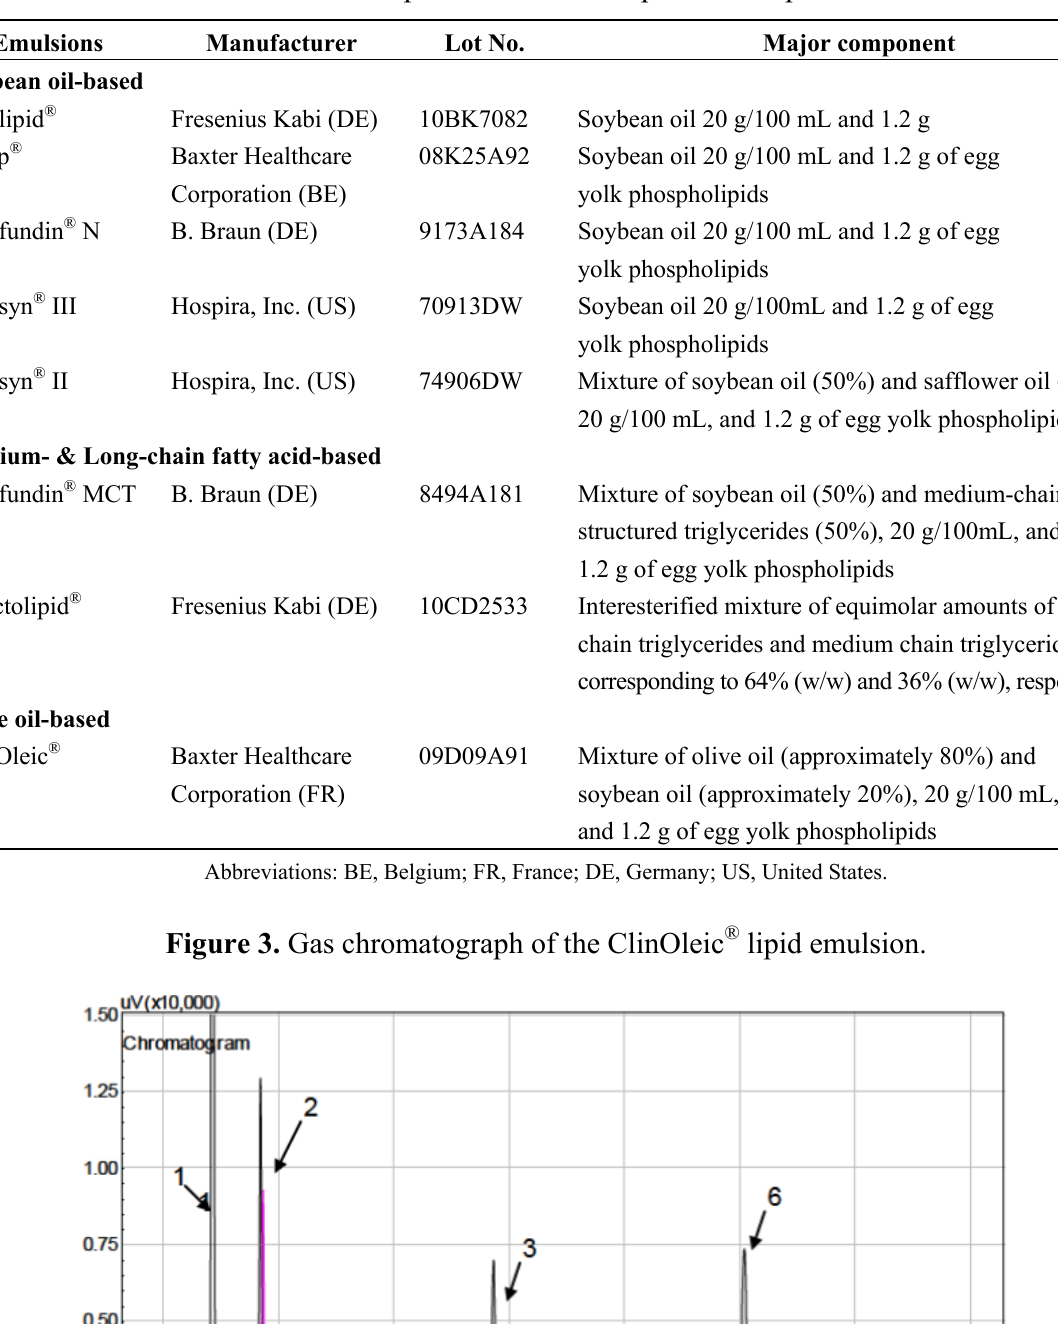
Table 3. The content specifications of the parenteral lipid emulsions.